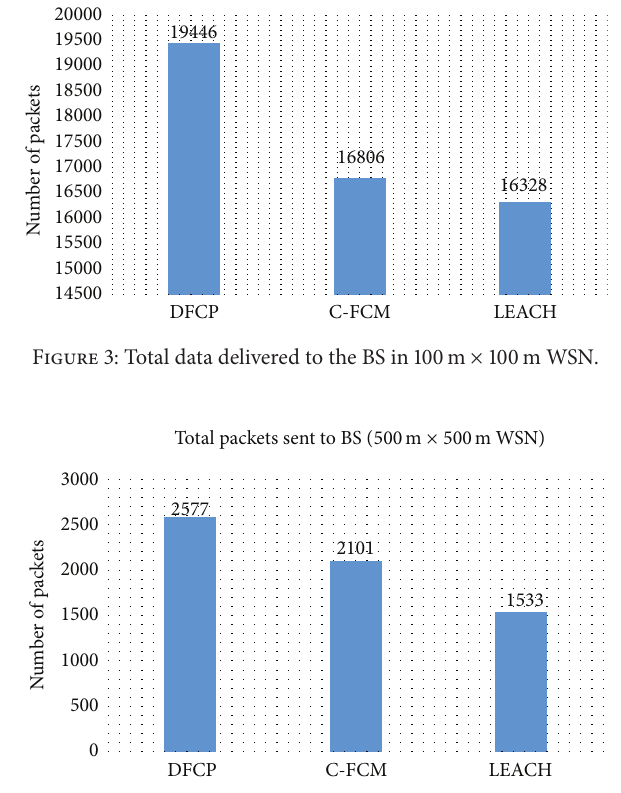
Figure 6: Network lifetime for 500 m × 500 m